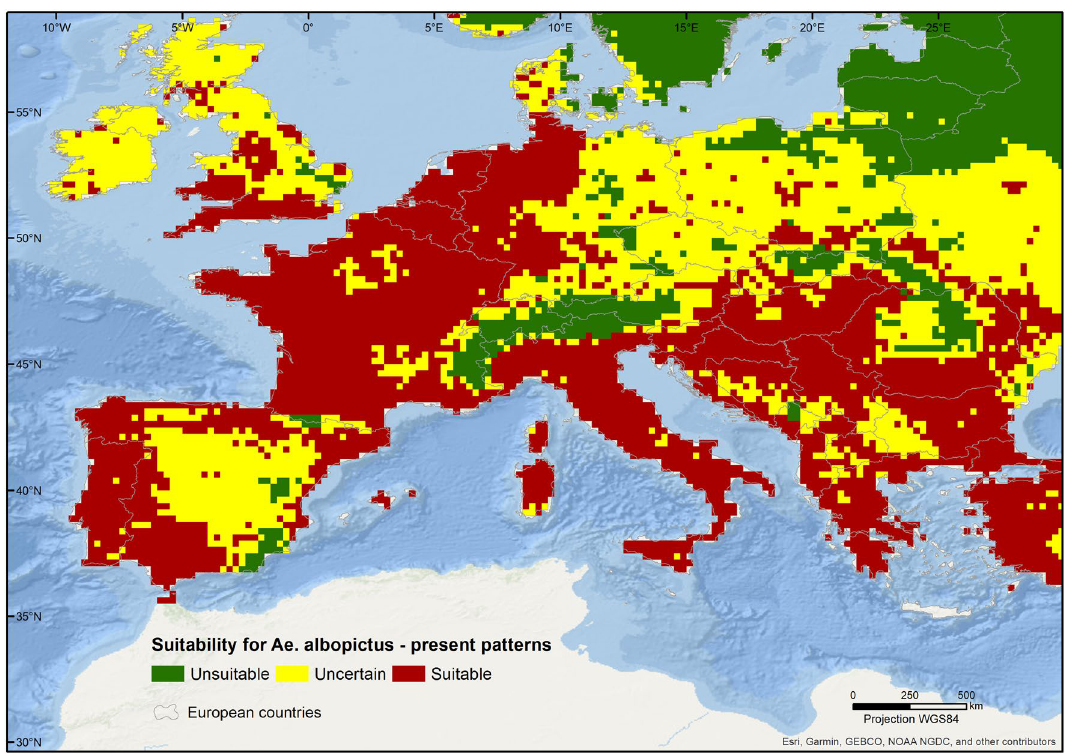
Figure 1. Patterns of consensus among published predictions of current habitat suitability for Aedes albopictus in Europe. Suitable and unsuitable areas result from the agreement of 5 or more predictions. The map was created using ArcGIS v. 10.6.1 (https:// www. arcgis.